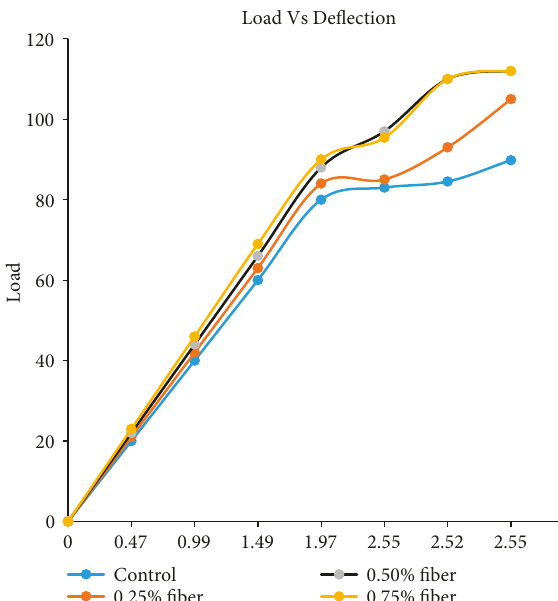
Figure 10: Comparison between load-deflection curves for control beam and strengthening beams for set